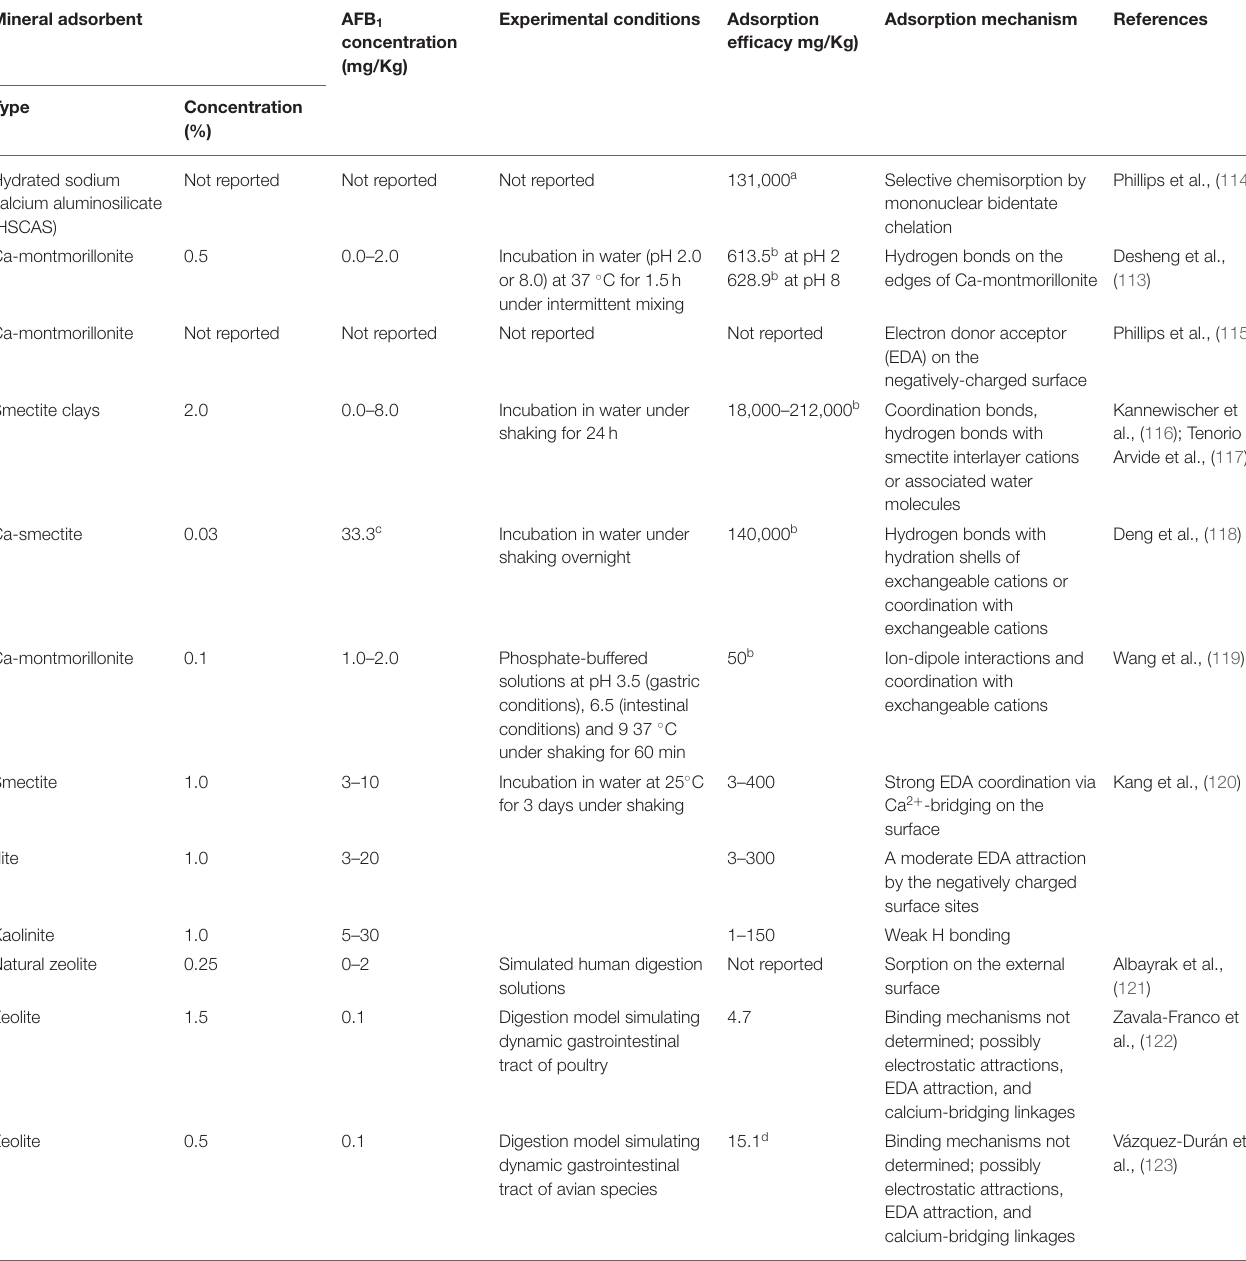
TABLE 2 | Adsorption mechanisms of AFB 1 by raw mineral adsorbents determined by in vitro trials (113). Mineral